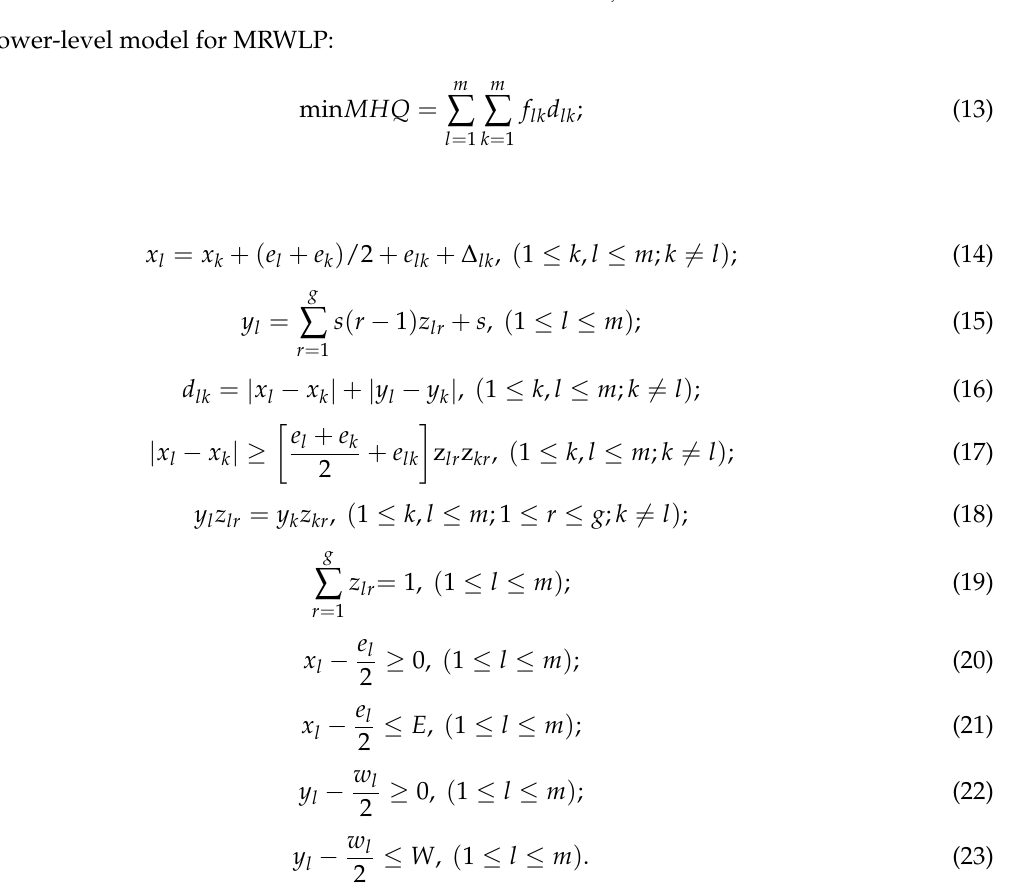
Figure 5. Two cases of calculating dt ijk